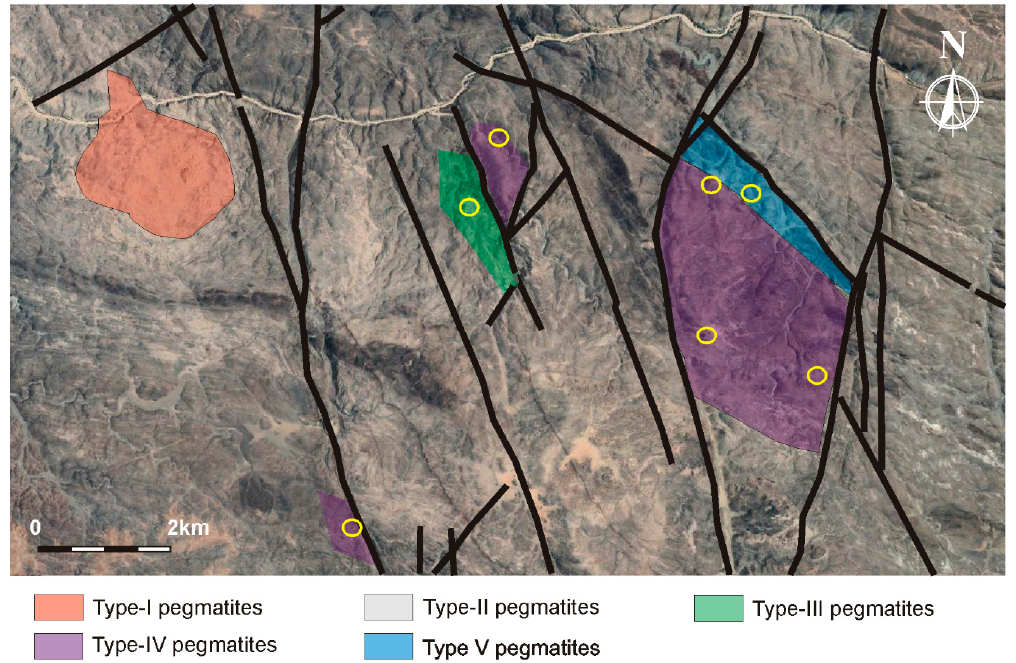
Figure 2. Google Earth satellite image showing the distribution of the Giraúl pegmatite types. Type-II pegmatites occur over all the area. Circles indicate outcrops of mined pegmatites.